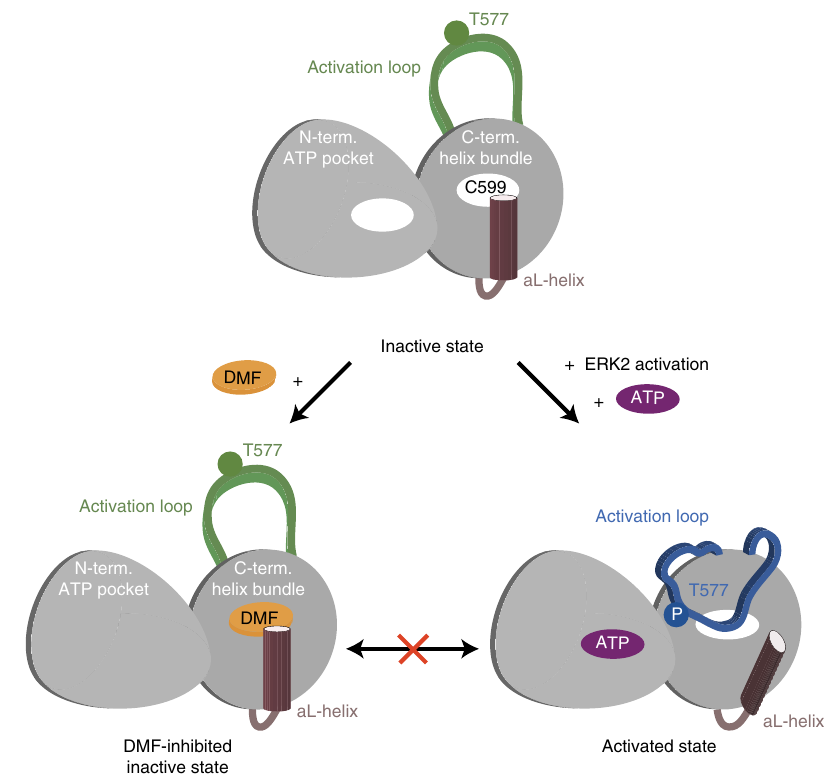
Fig. 5 Model of DMF inhibition. Schematic fi gure of the activation loop transition between inactive and activated state of the C-terminal kinase domain (consisting of the ATP binding domain and the helix bundle domain). DMF targets an allosteric site and blocks kinase activation, and vice